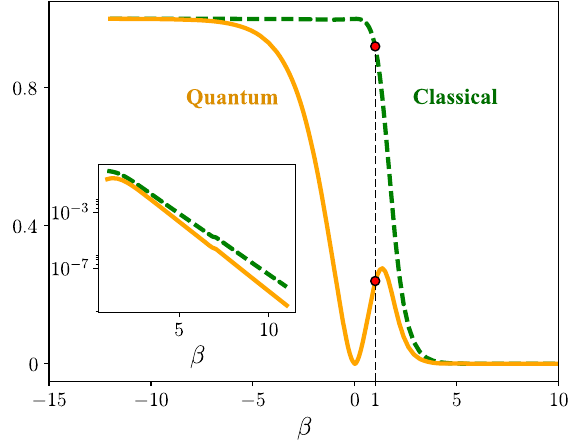
FIG. 6. Classical memory C μ ð β Þ and quantum memory C q ð β Þ versus β for biased sampling of the Perturbed Coins Process ’ rare sequence classes: See Fig. 5, with p ¼ 0 . 6 and q ¼ 0 . 8 . As the inset shows, for large β , both classical and quantum memories decay exponentially with β , but the quantum memory decays faster. The vertical dashed black line and two red markers at β ¼ 1 show the memory costs to generate typical sequences.